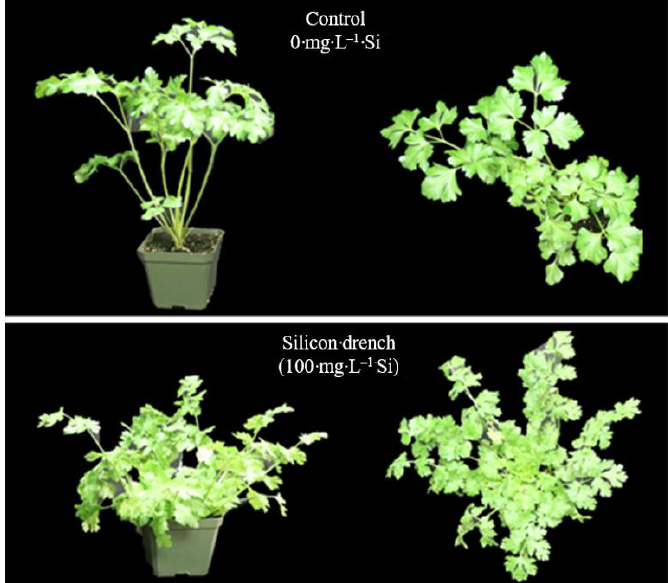
Figure 1. Effects of a no supplemental silicon (Si) control versus a Si substrate drench treatment on plant growth and morphology of parsley. Left and right photos consist of side and top views, respectively. The visual appearance of parsley was not different between the Si drench and Si foliar spray treatment (not